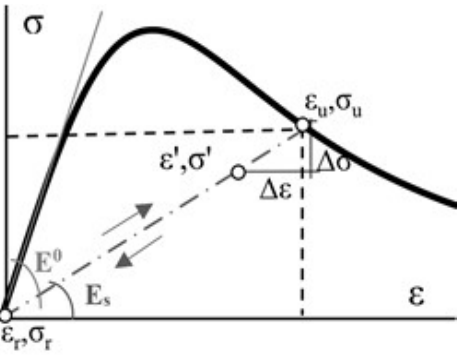
Figure 2. Secant